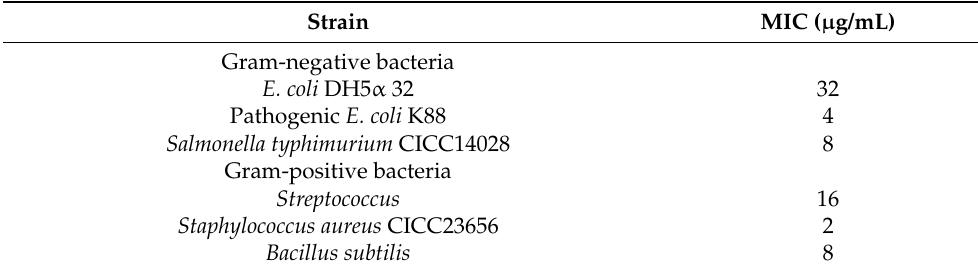
Table 1. MIC of PNKL produced by E. coli Rosetta